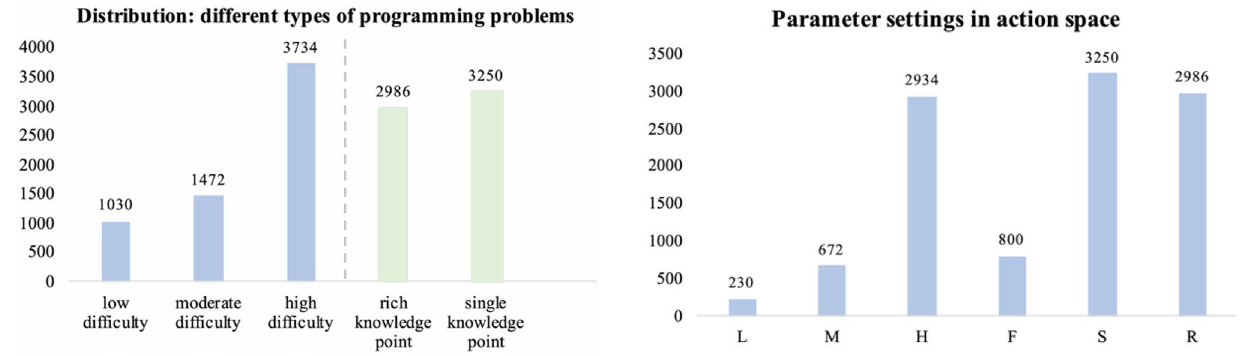
Fig. 10 The specific values of each parameter in the action space: the figure on the left means the number distribution of different types of pro- gramming problems, and the figure on the right means the parameter settings in action